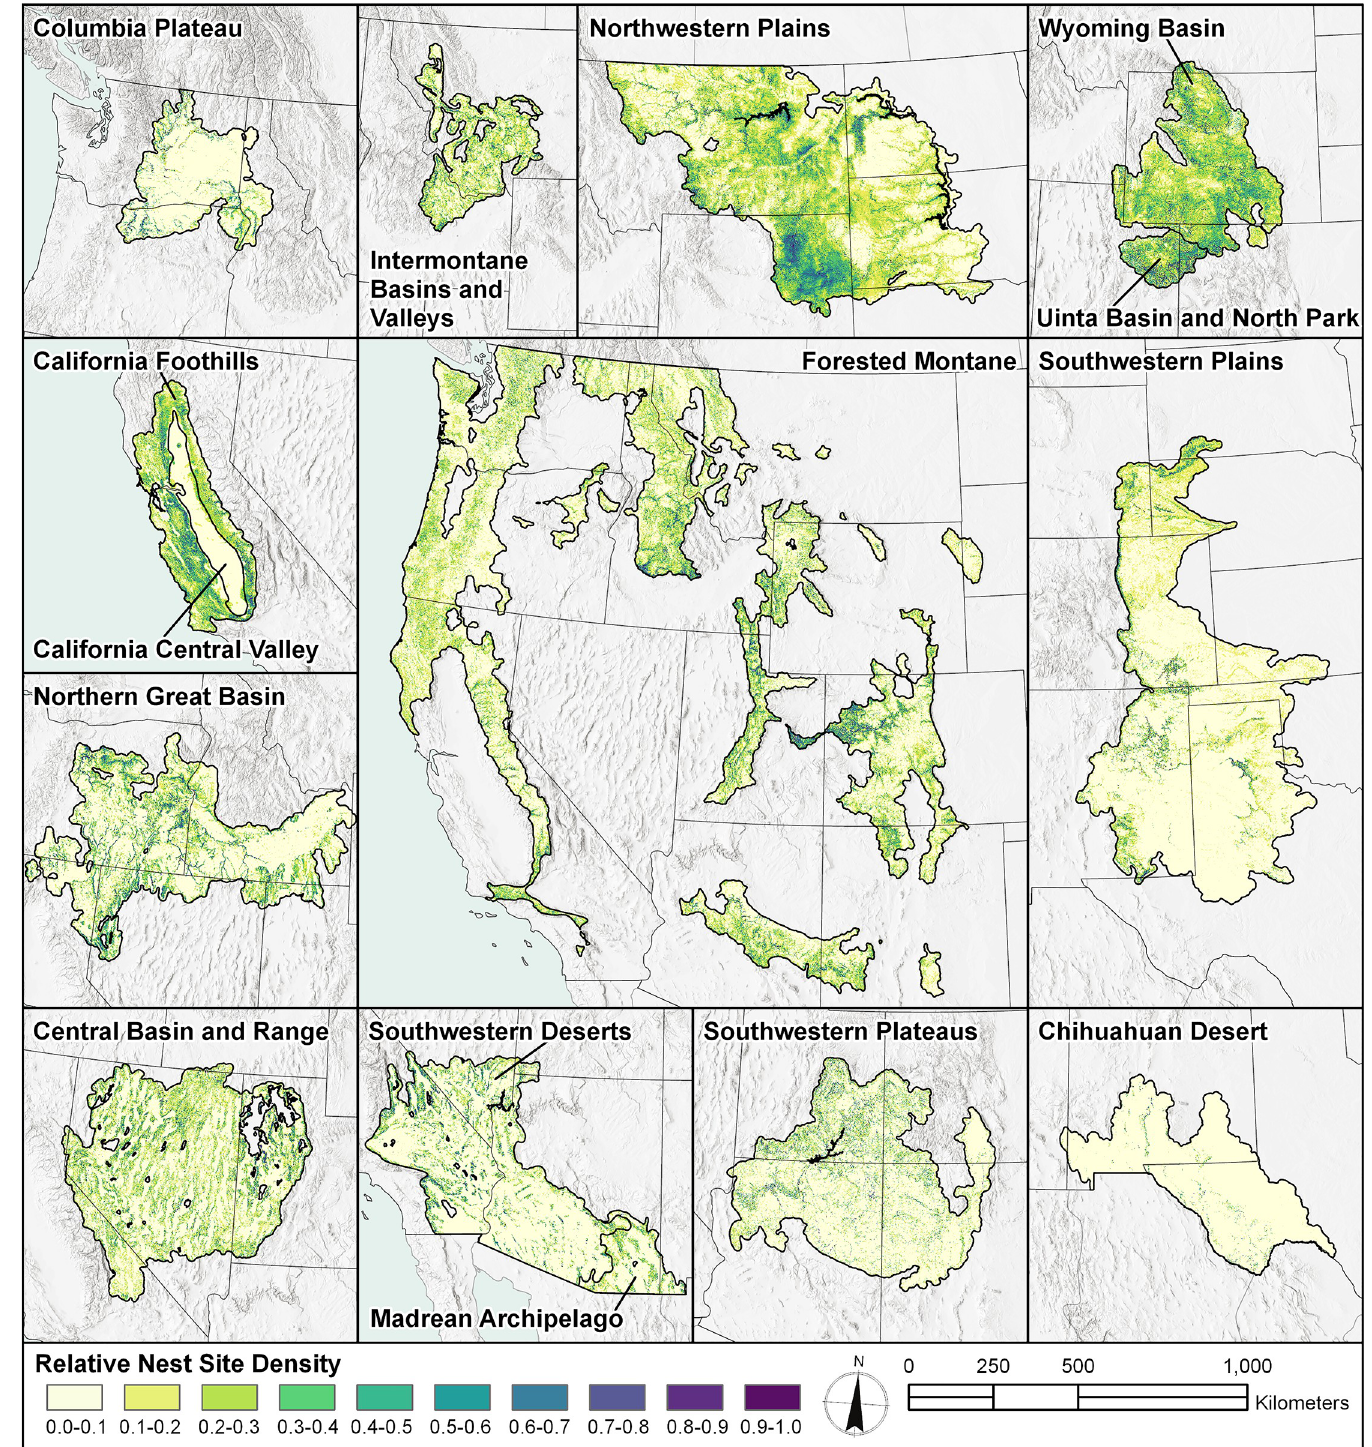
Fig 7. Maps of the distribution of RND in all regions.